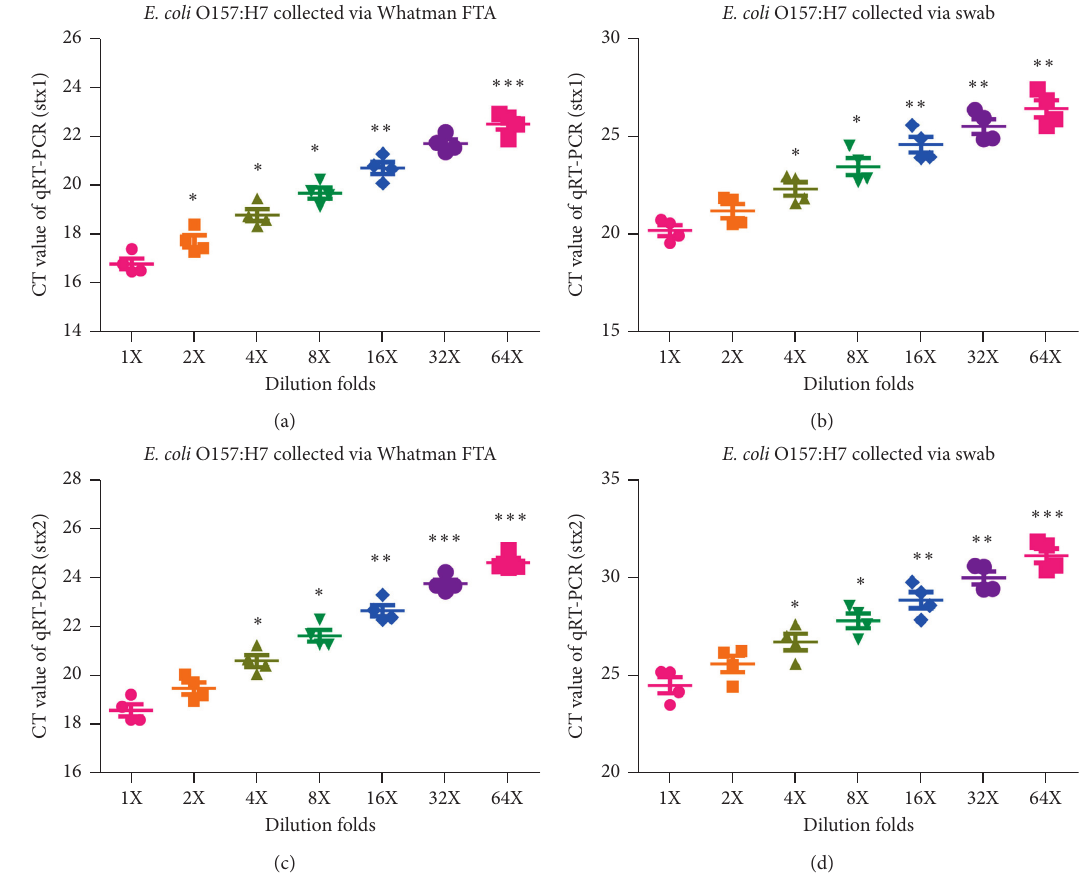
Figure 2: CT values of Escherichia coli O157:H7 genes in samples on Whatman FTA elute cards are higher than those on swabs. (a) Expression level of the stx1 gene in a serially diluted laboratory strain of Escherichia coli O157:H7 samples on Whatman FTA cards detected by RT-qPCR ( n � 6, ∗ P < 0 . 05, ∗∗ P < 0 . 01, and ∗∗∗ P < 0 . 001). (b) Expression level of the stx1 gene in a serially diluted laboratory strain of Escherichia coli O157:H7 samples on swabs detected by RT-qPCR ( n � 6, ∗ P < 0 . 05 and ∗∗ P < 0 . 01). (c) Expression level of the stx2 gene in a serially diluted laboratory strain of Escherichia coli O157:H7 samples on Whatman FTA cards detected by RT-qPCR ( n � 6, ∗ P < 0 . 05, ∗∗ P < 0 . 01, and ∗∗∗ P < 0 . 001). (d) Expression level of the stx2 gene in a serially diluted laboratory strain of Escherichia coli O157:H7 samples on swabs detected by RT-qPCR ( n � 6, ∗ P < 0 . 05, ∗∗ P < 0 . 01, and ∗∗∗ P < 0 . 001). RT-qPCR: reverse transcription-quantitative PCR; FTA: Flinders Technology